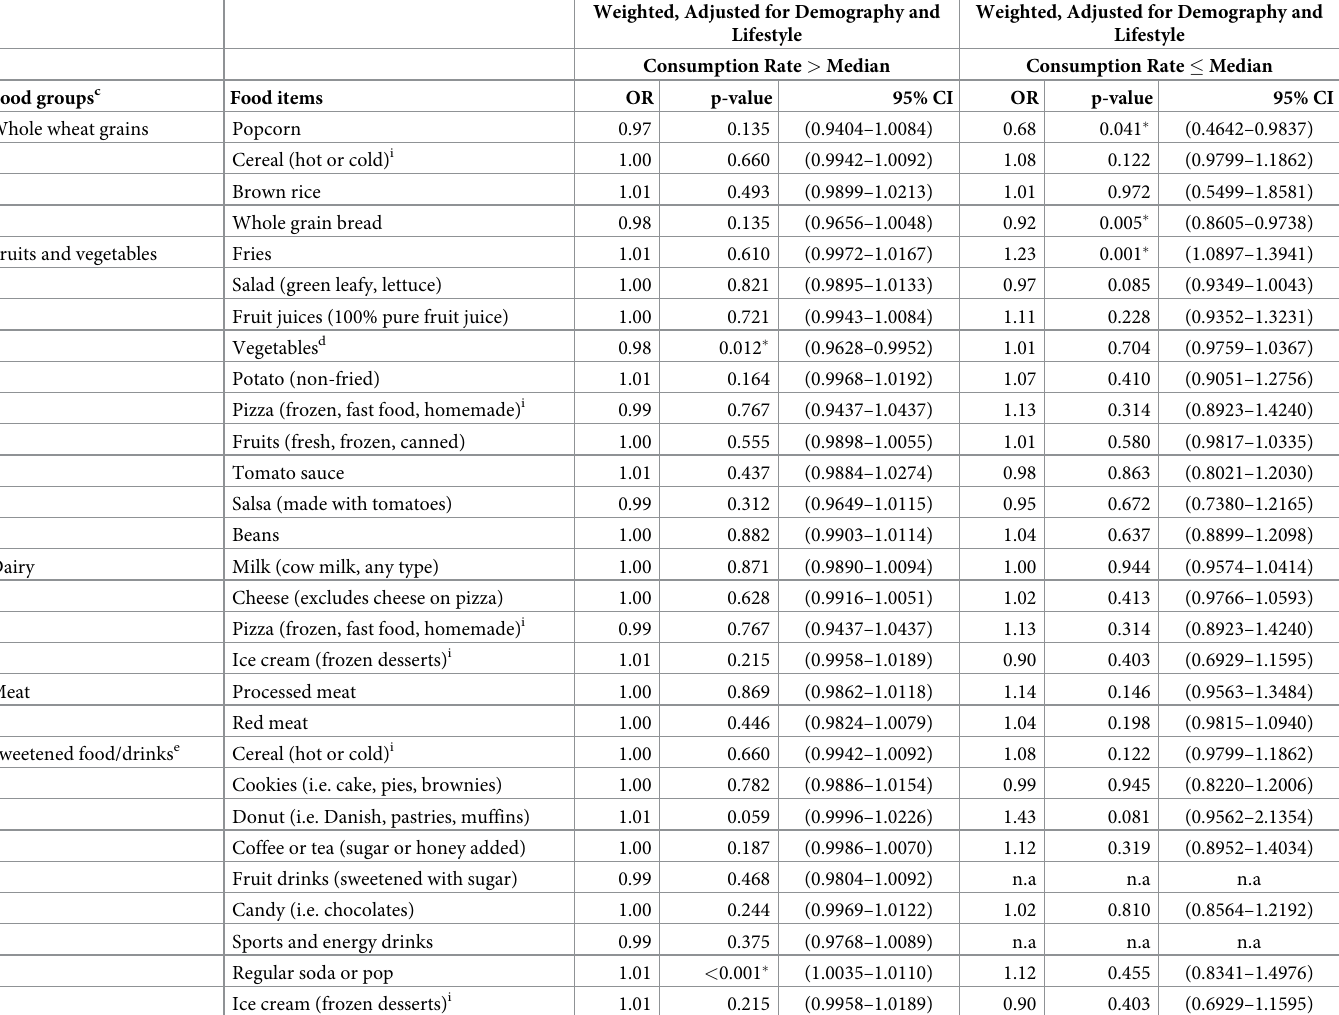
Table 4. Association (OR h ) of IBD and increasing consumption frequency in US subpopulation of > median or � median eating pattern (Adjusted for demography and lifestyle), NHIS 2015 a,b .